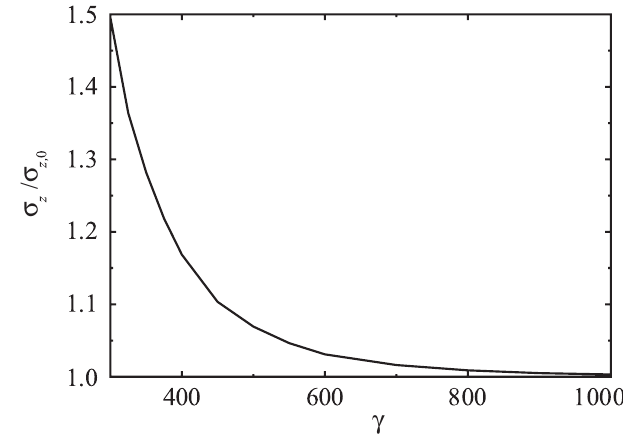
FIG. 7. Debunching (cid:5) z ð z ¼ 1 m Þ =(cid:5) z ð z ¼ 0 Þ as a function of electron energy for the beam parameters: (cid:5) z ¼ 1 (cid:2) m , (cid:5) x ¼ 30 (cid:2) m , and I ¼ 50 kA